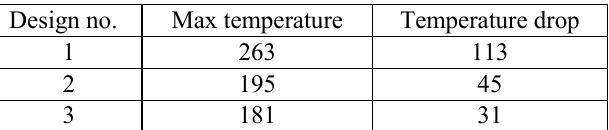
Table 1. Results for three